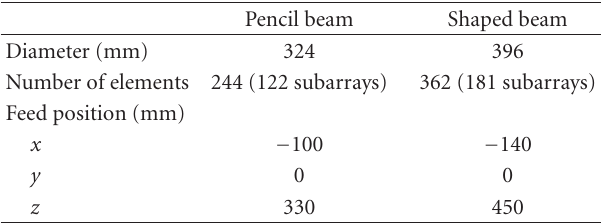
Table 2: Reflectarray antennas